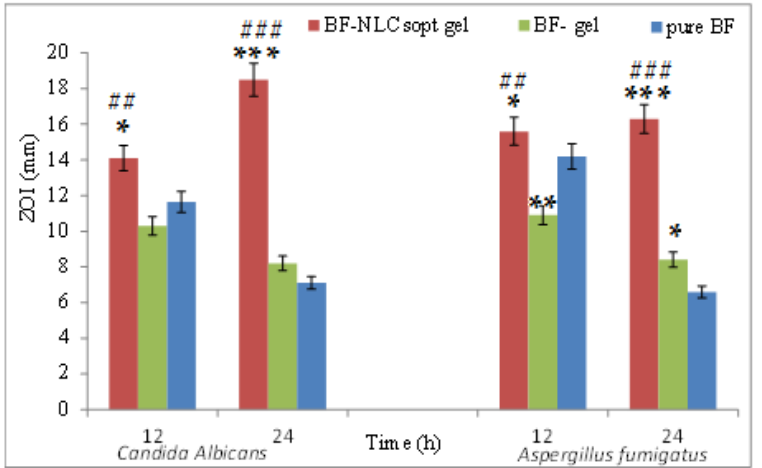
Figure 9. Antifungal study profile of Butenafine NLCopt gel, Butenafine gel, and Butenafine dispersion. Each study was performed in triplicate and data are shown as mean ± SD. * Comparison of antifungal activity of pure BF with BF-NLCsopt gel and BF-gel, Comparison of antifungal activity of BF-gel with BF-NLCsopt gel. *, **, ***, ##, ### show the significant differences at p < 0.05, p < 0.01, p < 0.001; respectively.